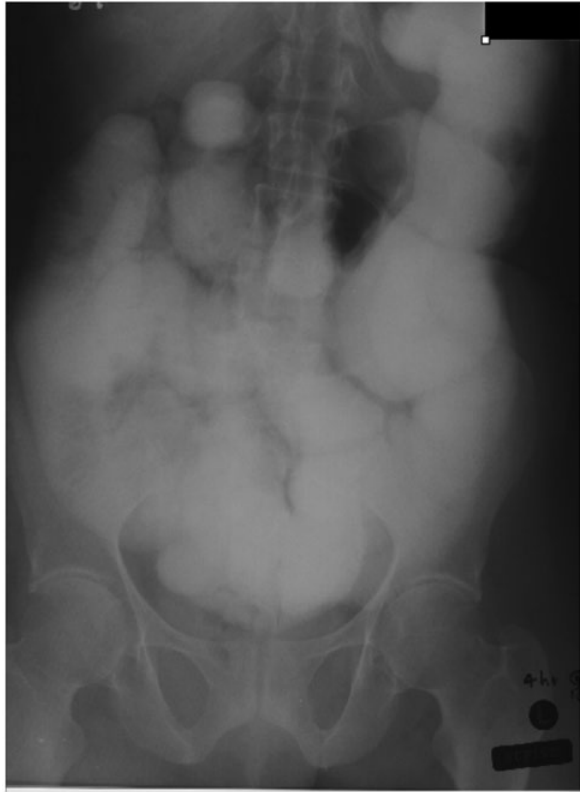
Figure 11: Small bowel follow-through study showing gross small bowel dilatation with dilution of barium and poor mucosal detail and poor delineation of the transition point due to overlapping bowel